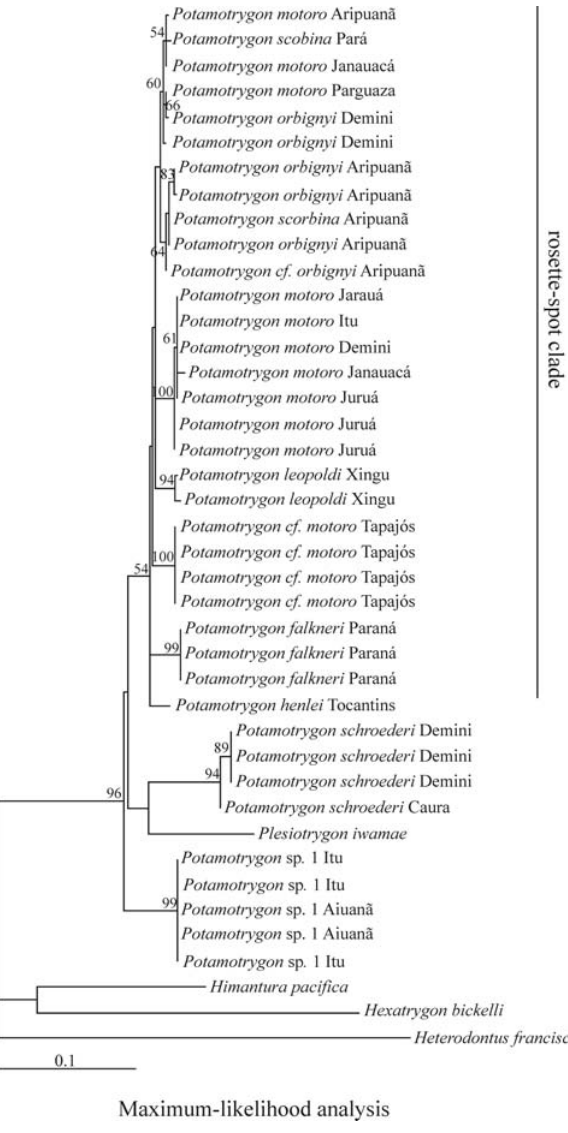
Figure 2 - Phylogenetic relationships of the potamotrygonids based on a Maximum-Likelihood phylogenetic analyses of mitochondrial COI se - quence data using GTR + inv substitution model. Plesiotrygon iwamae is sister to Potamotrygon schroederi and Potamotrygon sp.1 appears as the sister species of the family Potamotrygonidae. P. motoro , P. scobina , and P. orbignyi are non-monophyletic. The relationships among species of ro- sette-spot group are not well supported and branch lengths are short, evi- dence of a